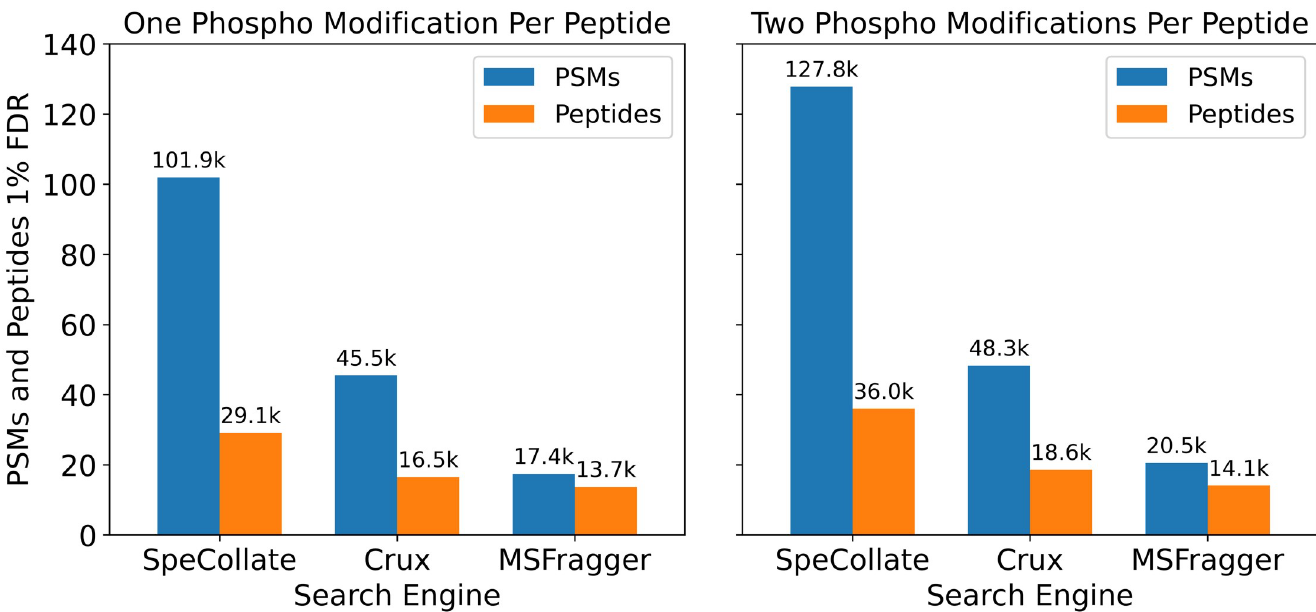
Fig 9. Closed search ( ± 5ppm) comparison against Crux and MSFragger using NIST Dataset with one phosphorylation modification per peptide (left) and two phosphorylation modifications (right). SpeCollate significantly outperforms Crux and MSFragger in both PSMs and number of peptides.